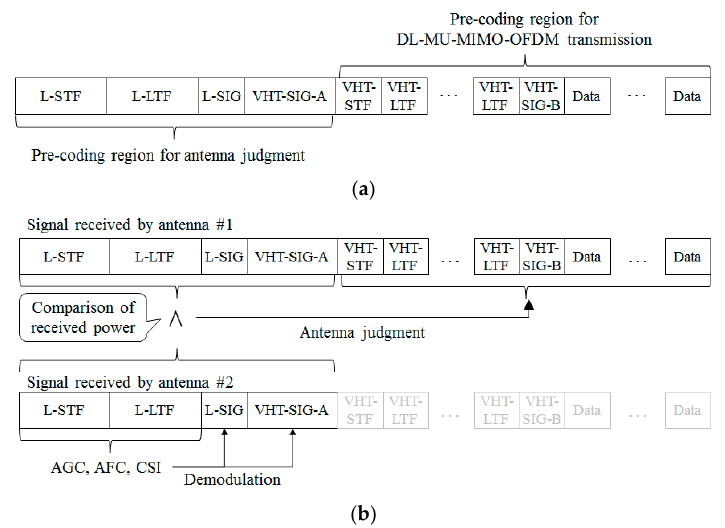
Figure 3. Frame format and receiving process for IEEE 802.11ac. ( a ) Example frame format with the proposed pre-cording region and general pre-coding region; and ( b ) the receiving process with the concept of the proposed antenna decision